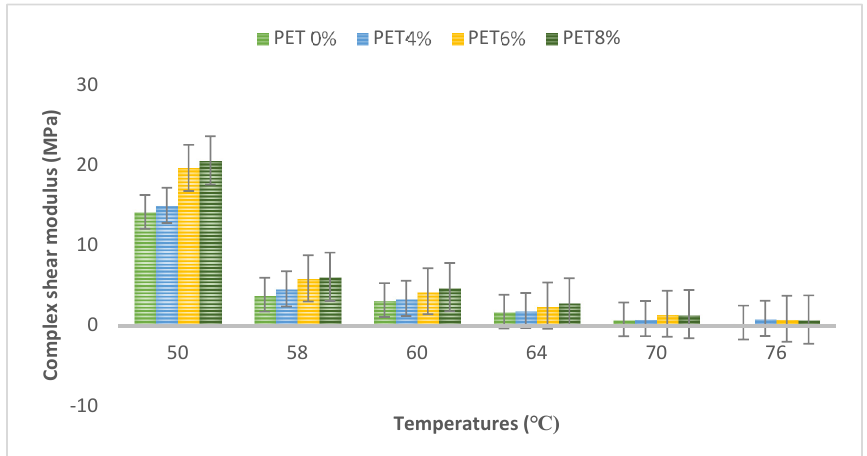
Figure 13. PET waste plastic effect on the complex shear modulus.